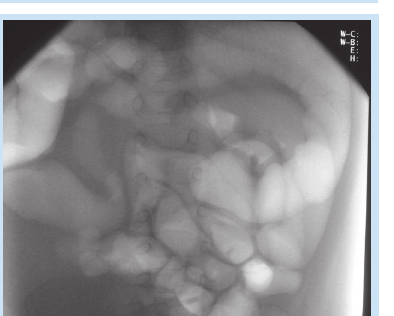
Fig. 1b. The balloon that is inflated in the rec- tum acts as a seal to prevent air leakage.